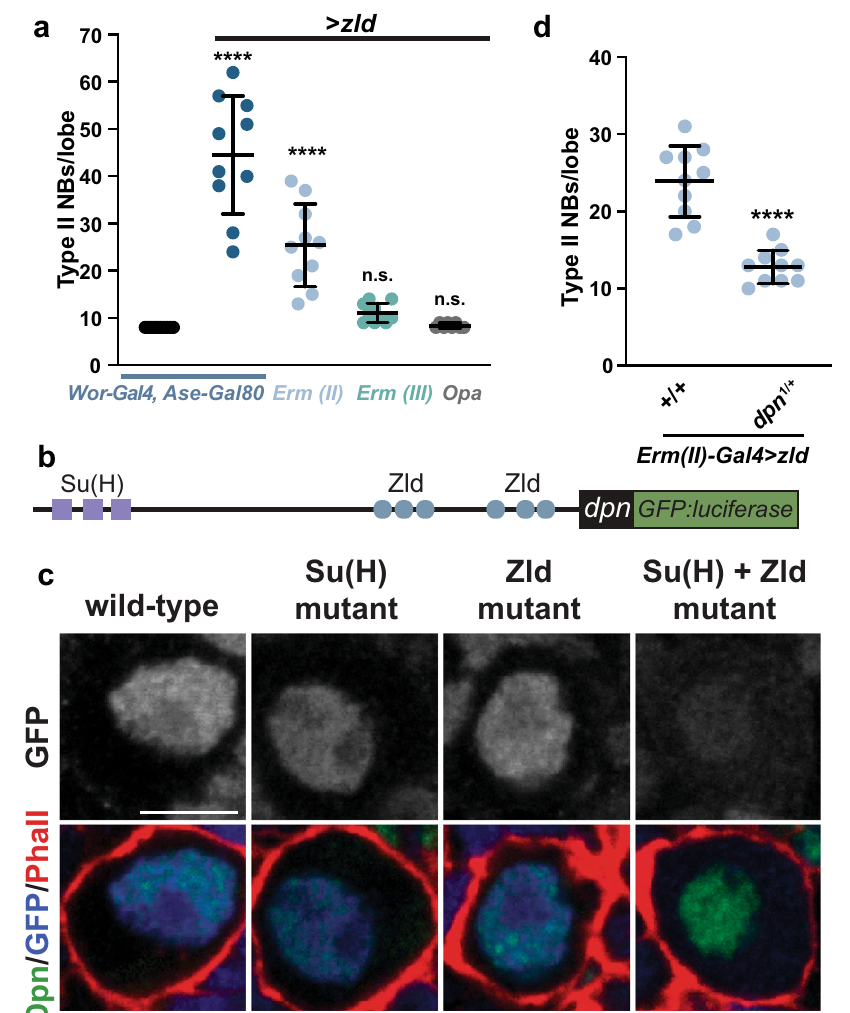
Fig. 2 Zld promotes an undifferentiated state by activating dpn expression. a Quanti fi cation of type II neuroblasts per lobe when Zld expression is driven by the indicated drivers (see Fig. 1a for expression timing). Mean number of type II neuroblasts is shown, and error bars show the standard deviation for a sample. Wor-Gal4, Ase-Gal80 (8 ± 0) n = 10 brains, Wor-Gal4, Ase-Gal80 > zld (44.5 ± 12.5) n = 10 brains, Erm-Gal4(II) > zld (25.4 ± 8.7) n = 10 brains,